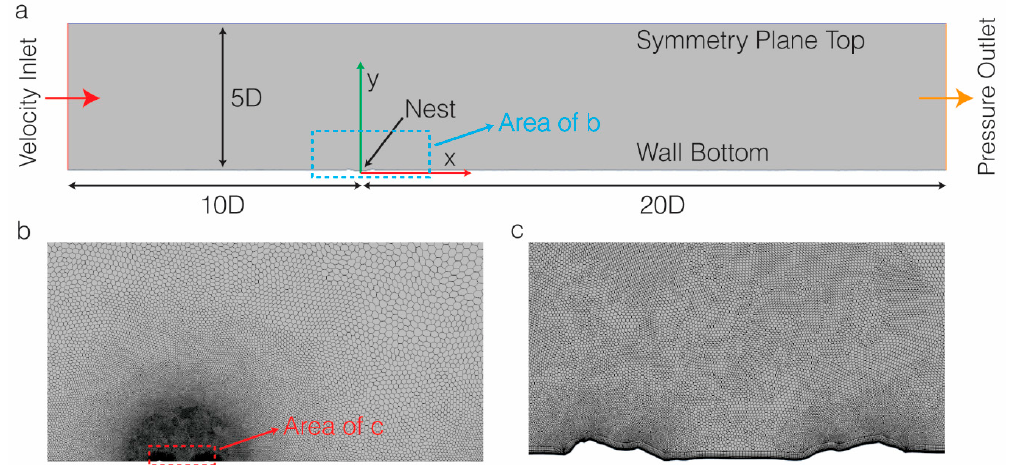
Figure 6. ( a ) Computational domain and boundary conditions used; ( b , c ) View of the mesh resolution used in the study with the flow from left to right. Finer mesh is used in the immediate vicinity of the nest with increasingly coarser mesh further away.